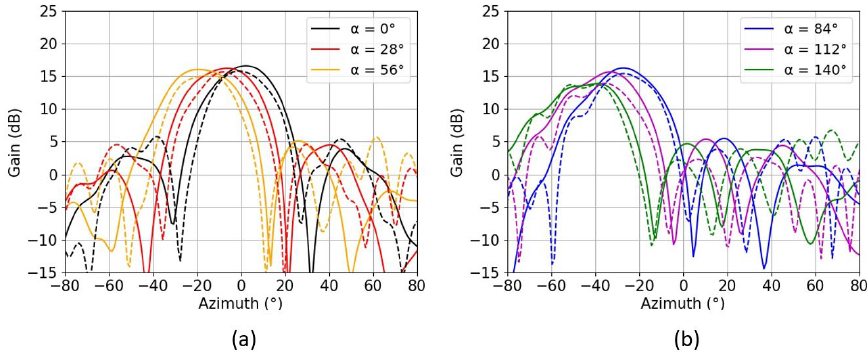
Figure 10. Radiation pattern in the E-plane (for measured - - and simulated -) for six different progressive phases α ranging from 0 ◦ to 56 ◦ ( a ) and from 84 ◦ to 140 ◦ ( b ), at 26.5 GHz.